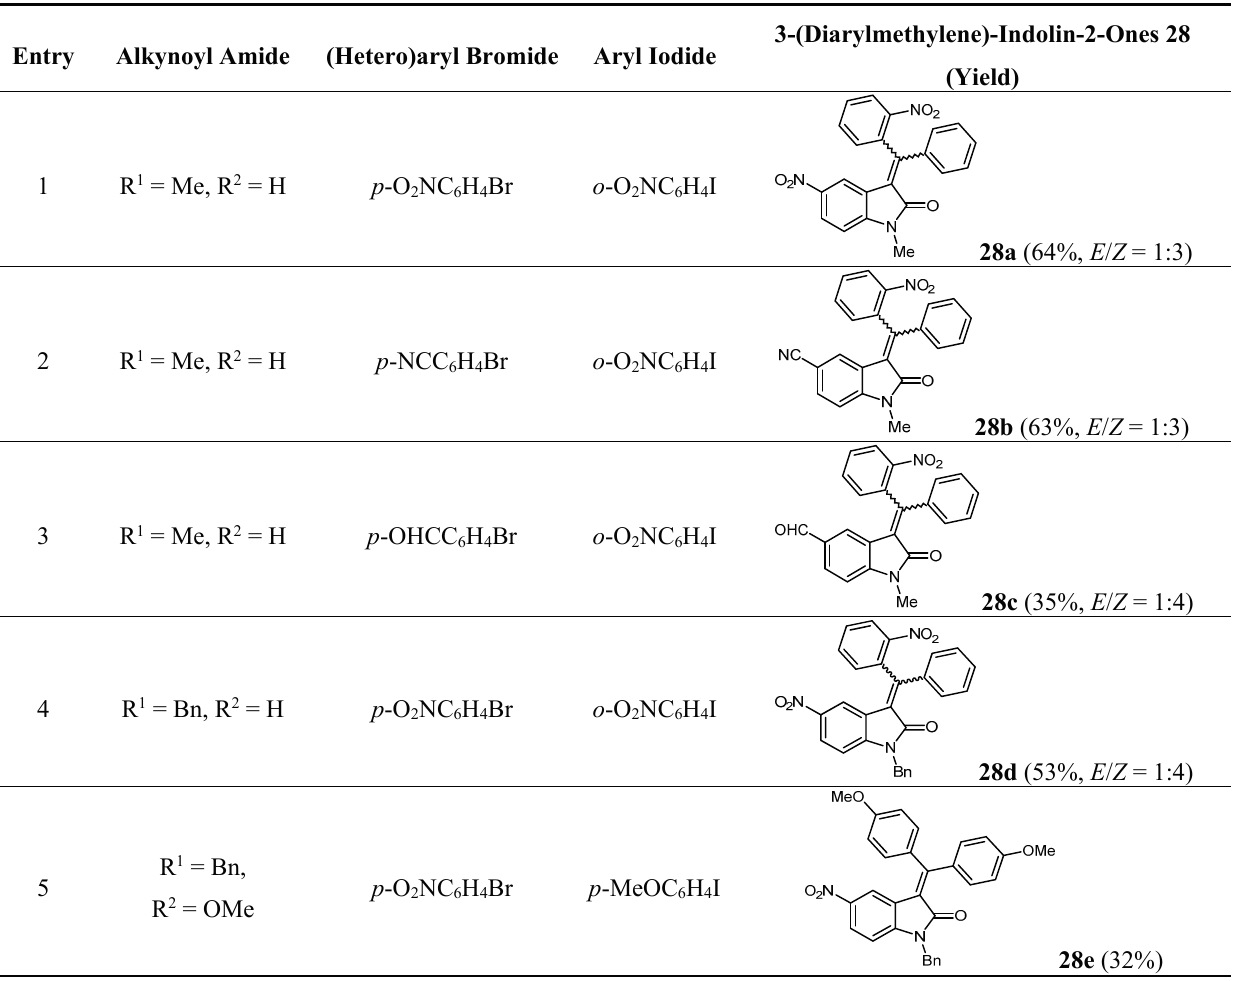
Table 9. Selected 3-(diarylmethylene)indolin-2-ones 28 via sequentially Pd-catalyzed N